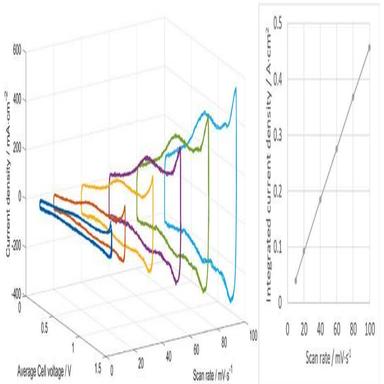
Right: cyclic voltammogram for an electrolysis stack at different scan rates, left: integrated current area over the scan rate.